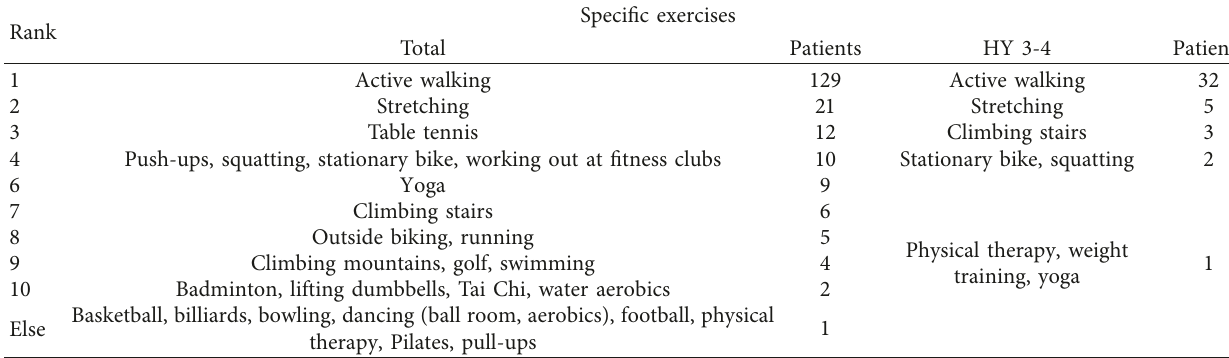
Table 2: Rank of the specific exercises reported by